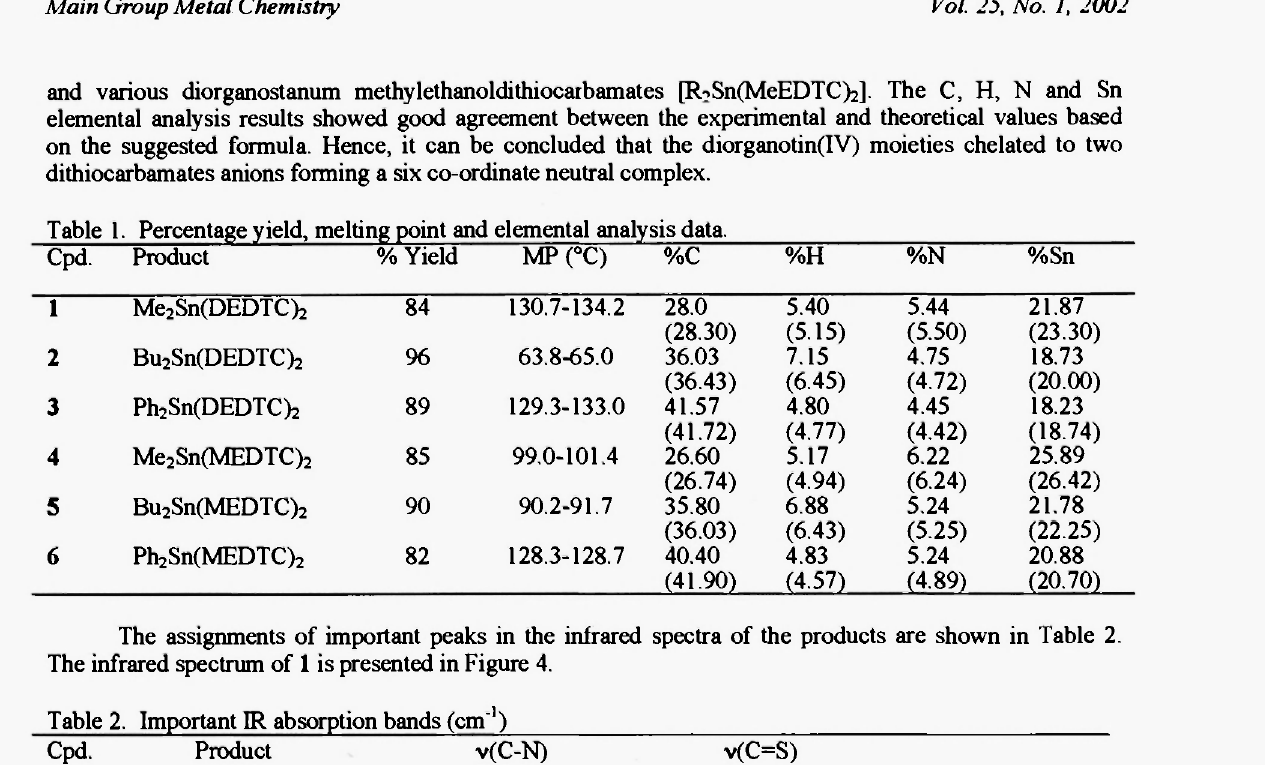
Table 2. Important IR absorption bands (cm' 1 ) Cpd.